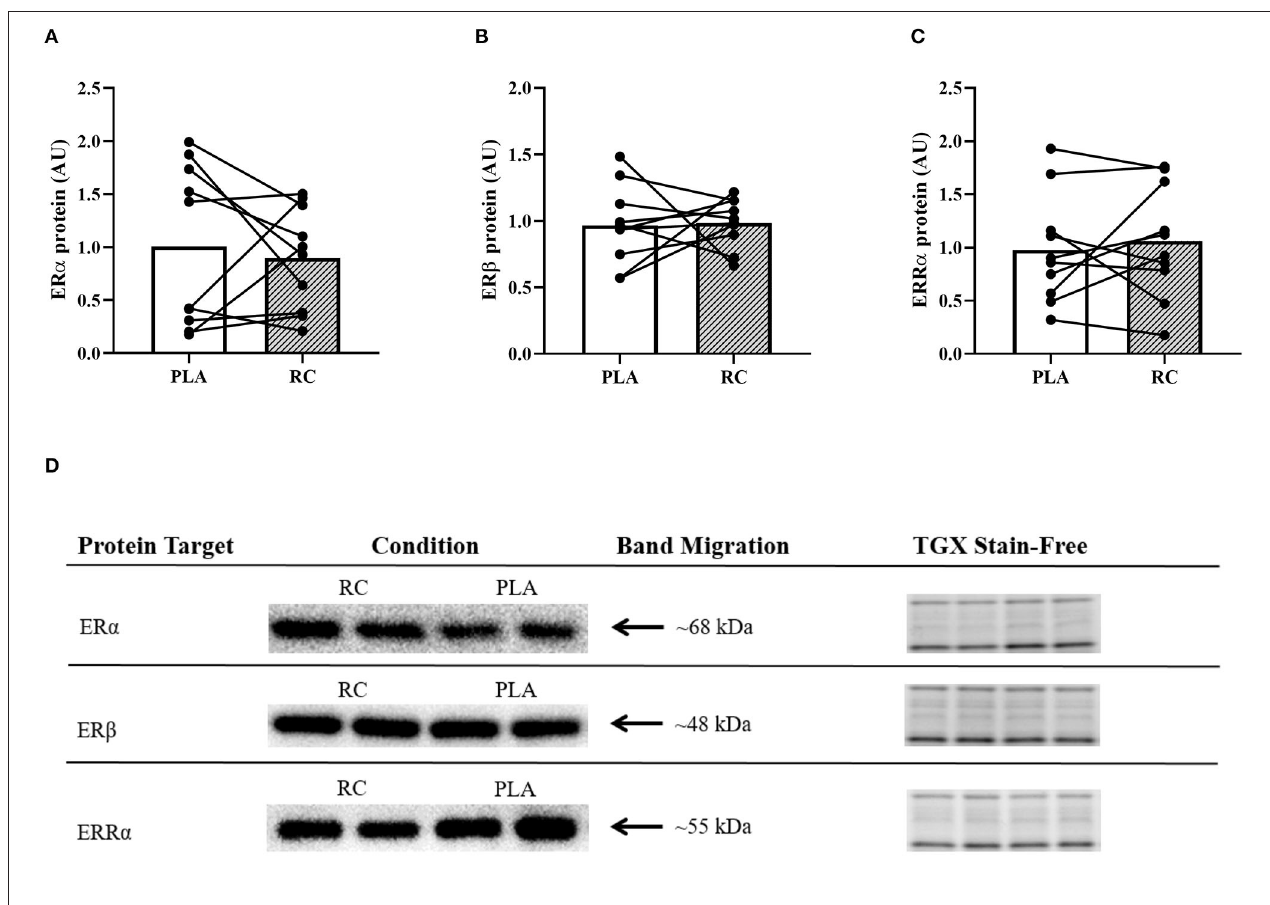
FIGURE 3 | Protein expression of estrogen and estrogen-related receptors in skeletal muscle from early post-menopausal women following two weeks of twice daily supplementation with placebo (PLA) or fermented red clover extract (RC) ( n = 10). (A) Estrogen receptor alpha (ER α ), (B) Estrogen receptor beta (ER β ), and (C) Estrogen-related receptor alpha (ERR α ). (D) Representative western blots and the corresponding TGX stain-free